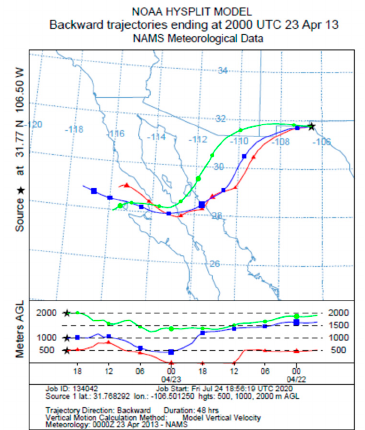
Figure 8. Backtrajectories for 23 April 2013.